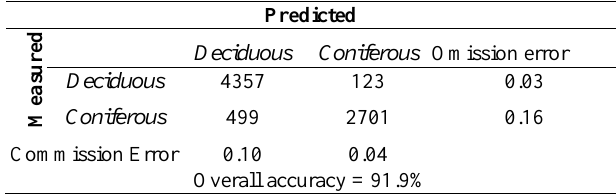
Table 5. Confusion matrix for coniferous-deciduous classification for MTN with use of 𝐿